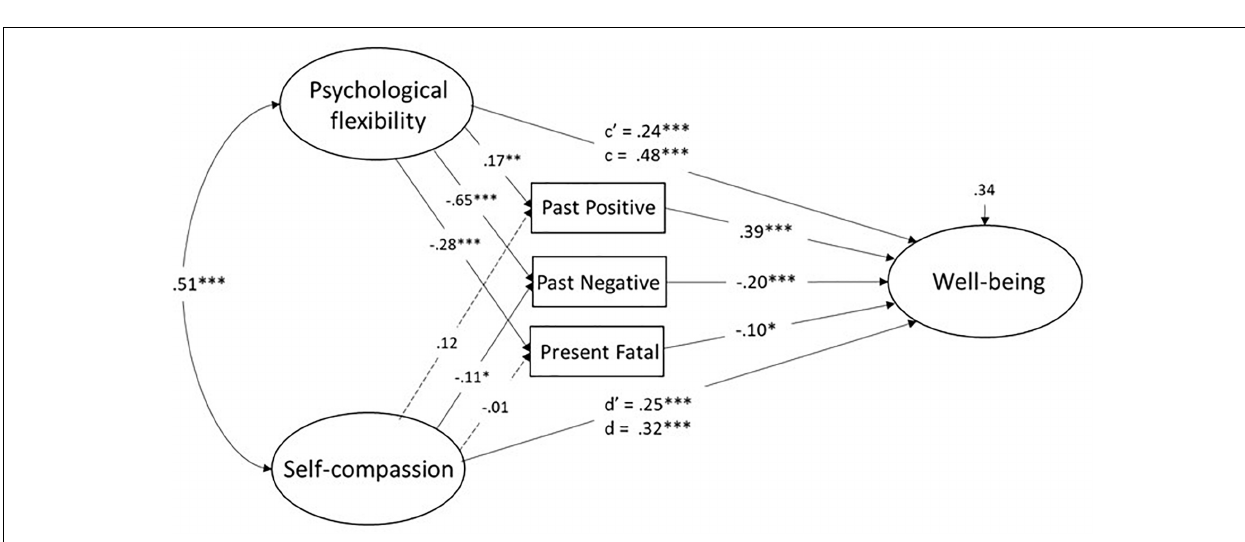
FIGURE 4 | Structural model with hypothetized links between involving psychological flexibility, self compassion, and well-being with separate ZTPI dimensions as mediators. Values are for standardized coefficents. c’ = direct effect, c = total